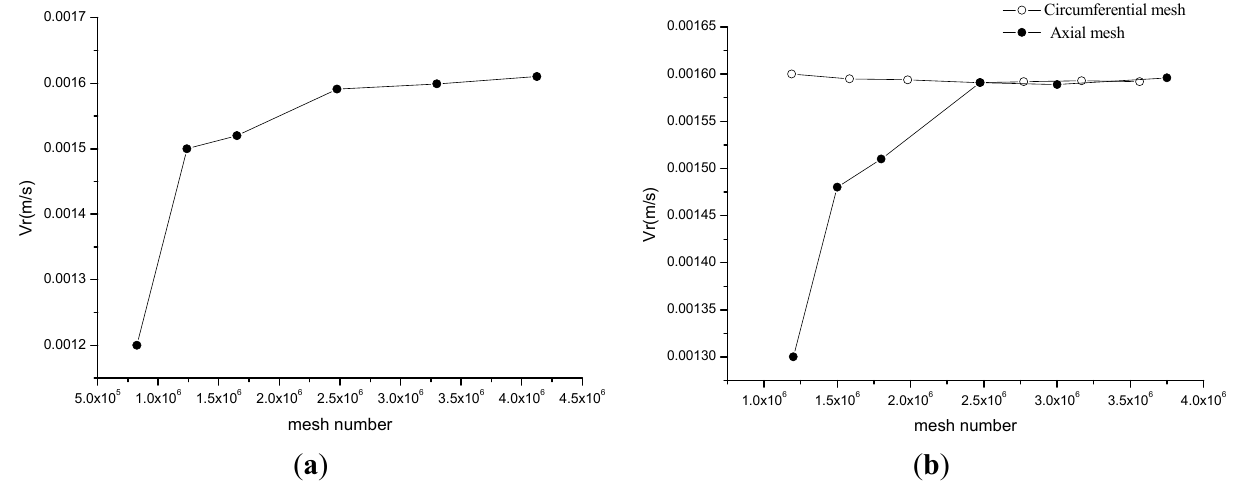
Figure 6. Simulation results with different grid number. ( a ) Different radial grid number; and ( b ) Different circumferential and axial grid